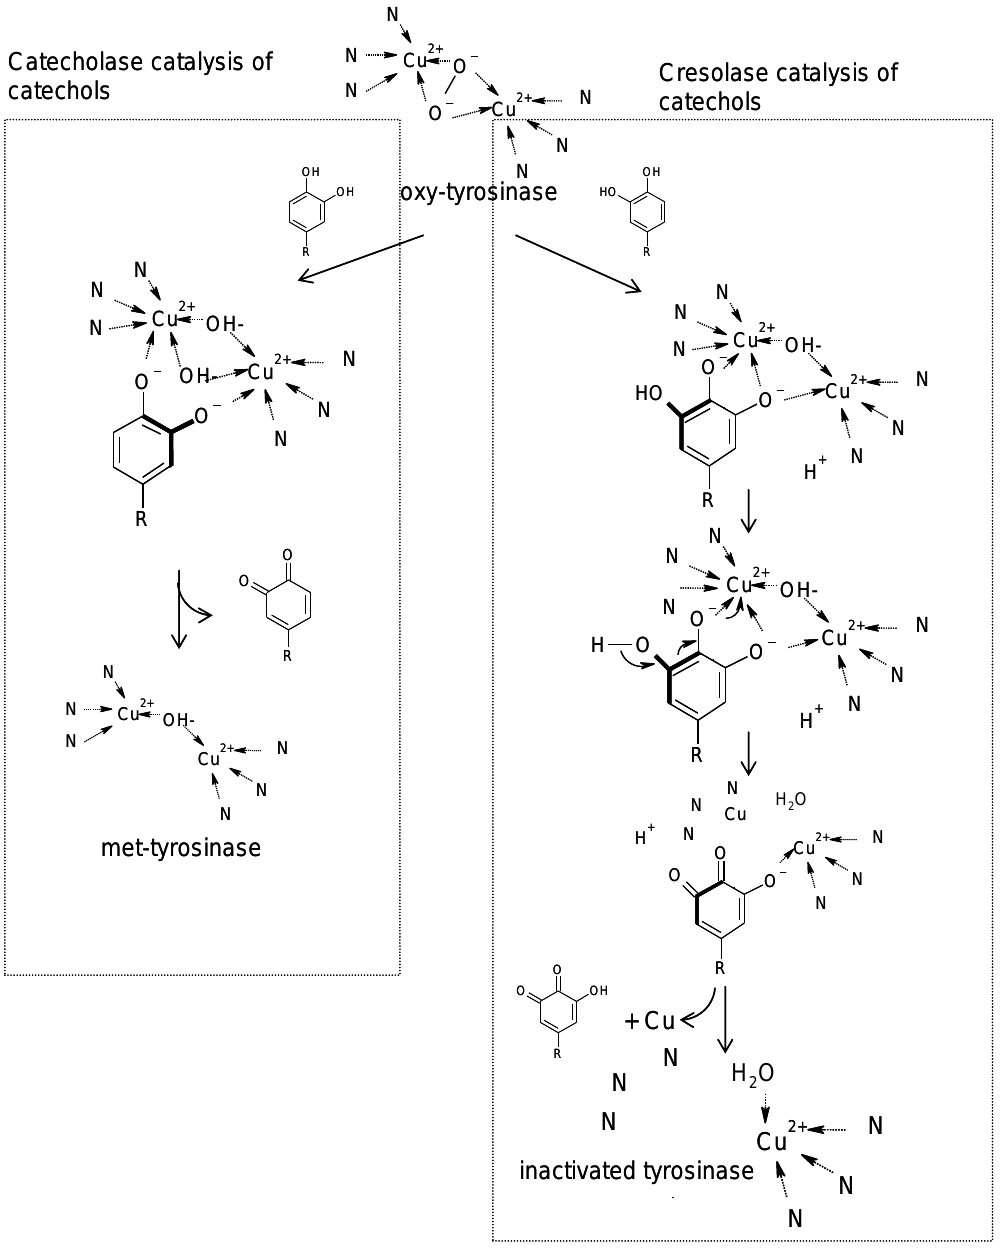
Figure 8. Molecular reaction mechanism of suicide inactivation of tyrosinase by the oxidation of an o -diphenol substrate. The curly arrows shows the effect of deprotonation leading to the reduction of copper from bivalent to zero-valent form, elimination of an o - quinone and inactivated tyrosinase